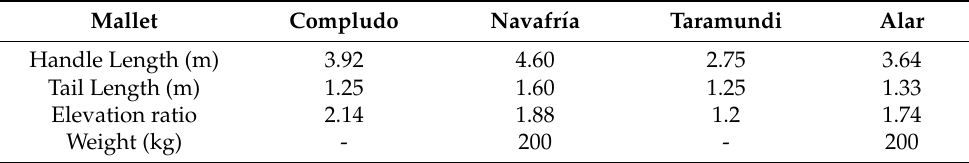
Figure 14. Bellows room. Source: own elaboration. Table 6. Hammer characteristics. Source: own